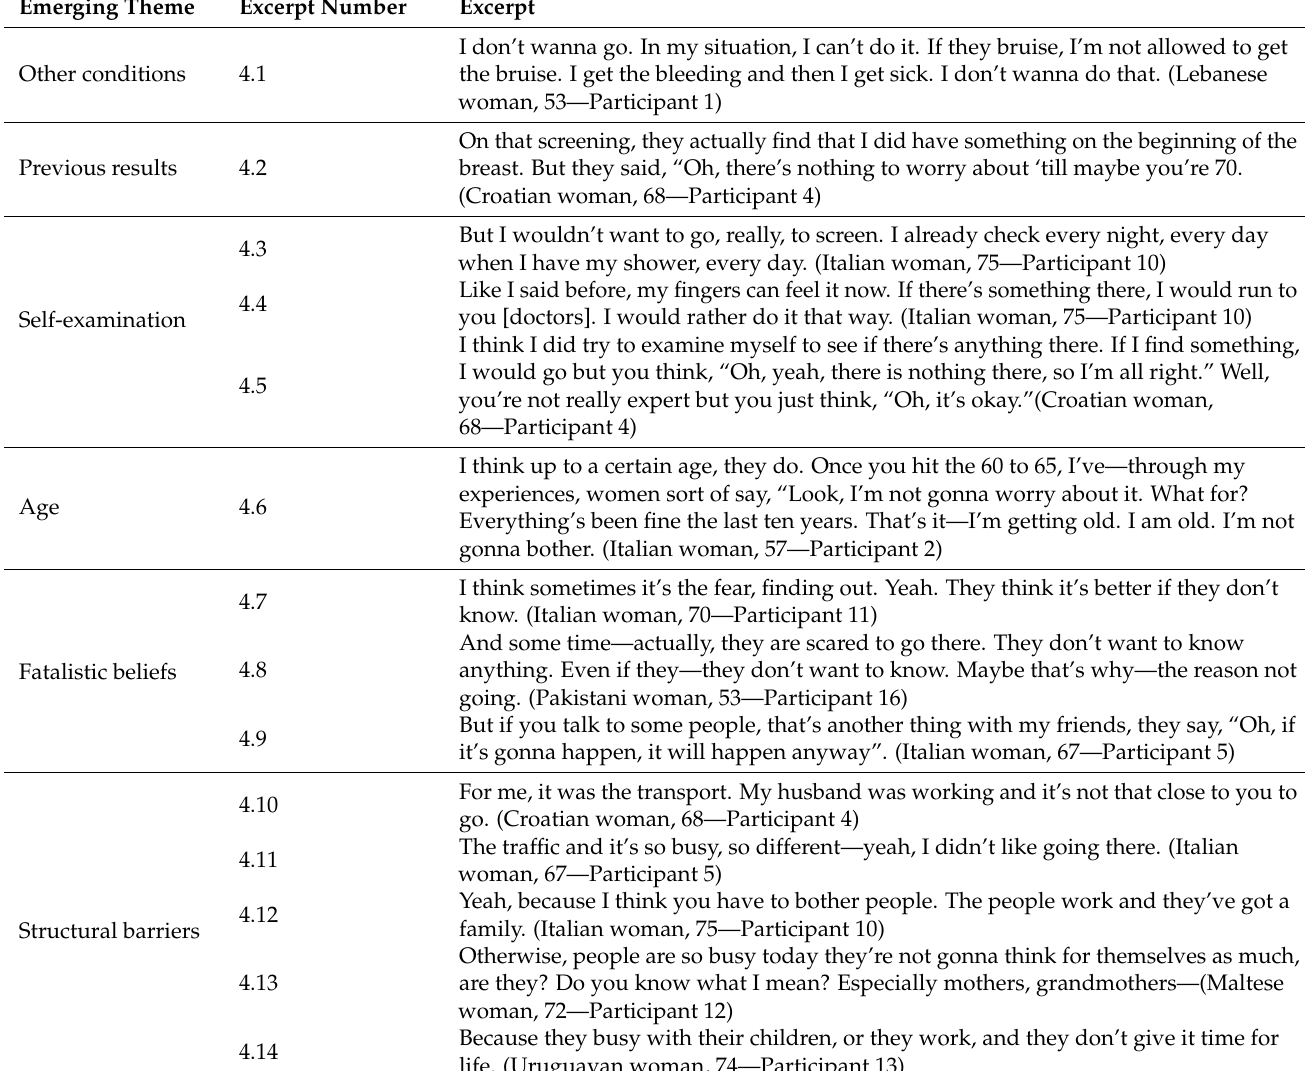
Table 4. Patient-reported personal barriers to breast